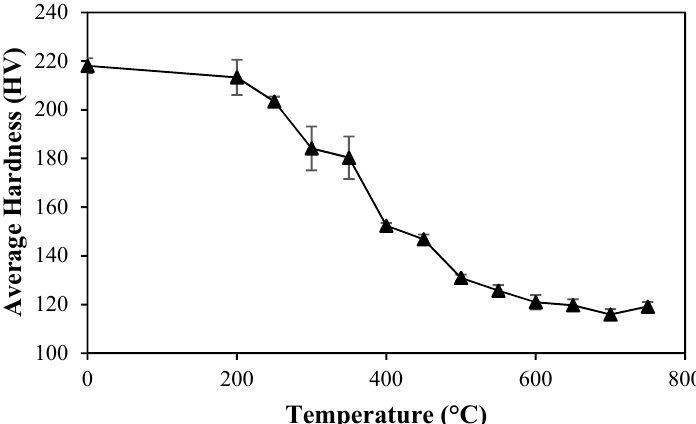
Figure 10. The strength coefficient ( a ) and strain-hardening exponent ( b ) of the samples by annealing temperature.